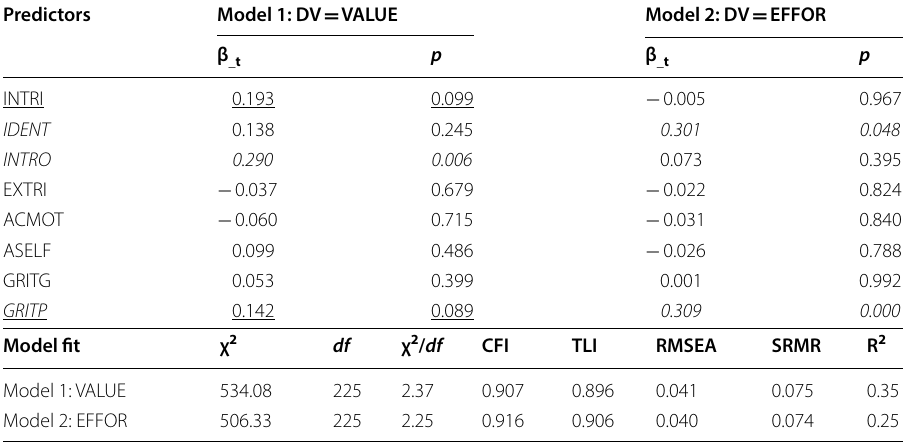
Table 5 Model fit and parameter estimates of the multivariate intercept/trait‑only “growth”